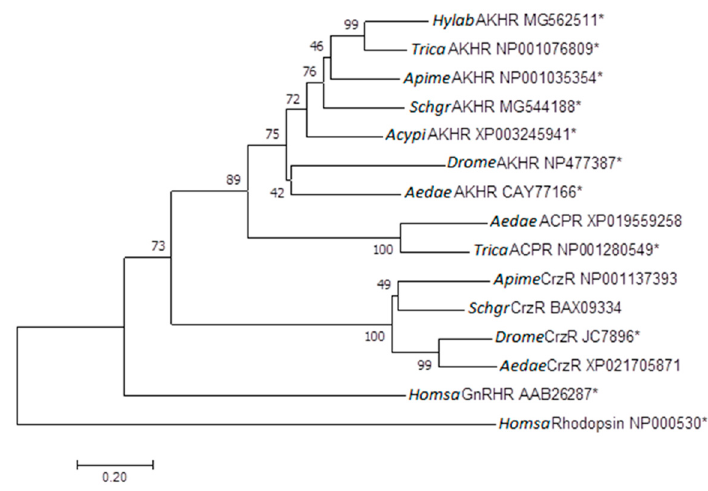
Figure 1. Phylogenetic analysis of the gonadotropin-releasing hormone (GnRH) receptor subfamily (i.e., GnRH/AKH/RPCH/ACP/Crz-type receptors) was inferred using the neighbour-joining method [44].